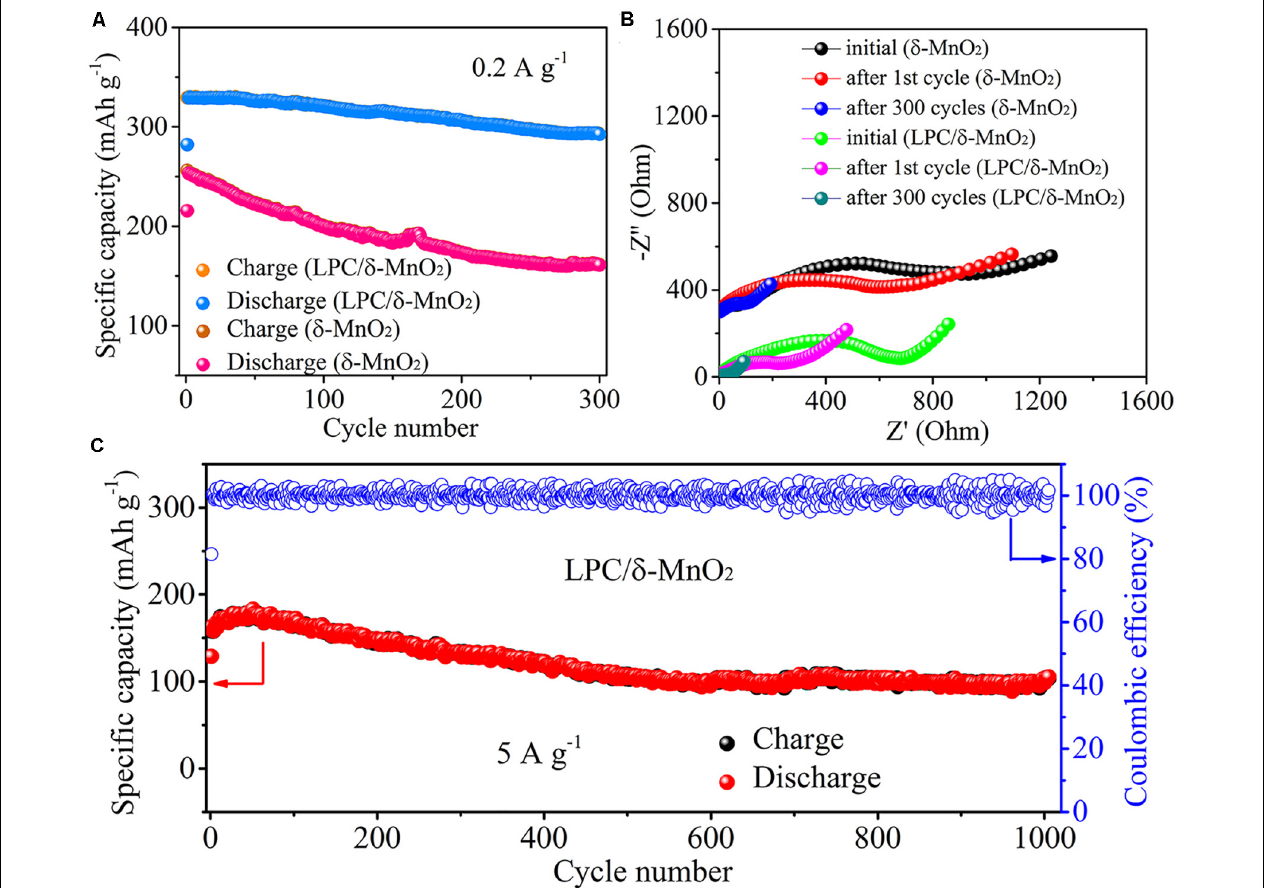
FIGURE 3 | (A) Cycling performances of LPC/ δ -MnO 2 and δ -MnO 2 at 0.2 A g - 1 . (B) Nyquist plots of the Zn–MnO 2 batteries with LPC/ δ -MnO 2 and δ -MnO 2 at different states during cycling. (C) Long-term cycling performances of LPC/ δ -MnO 2 at 5 A g - 1 .